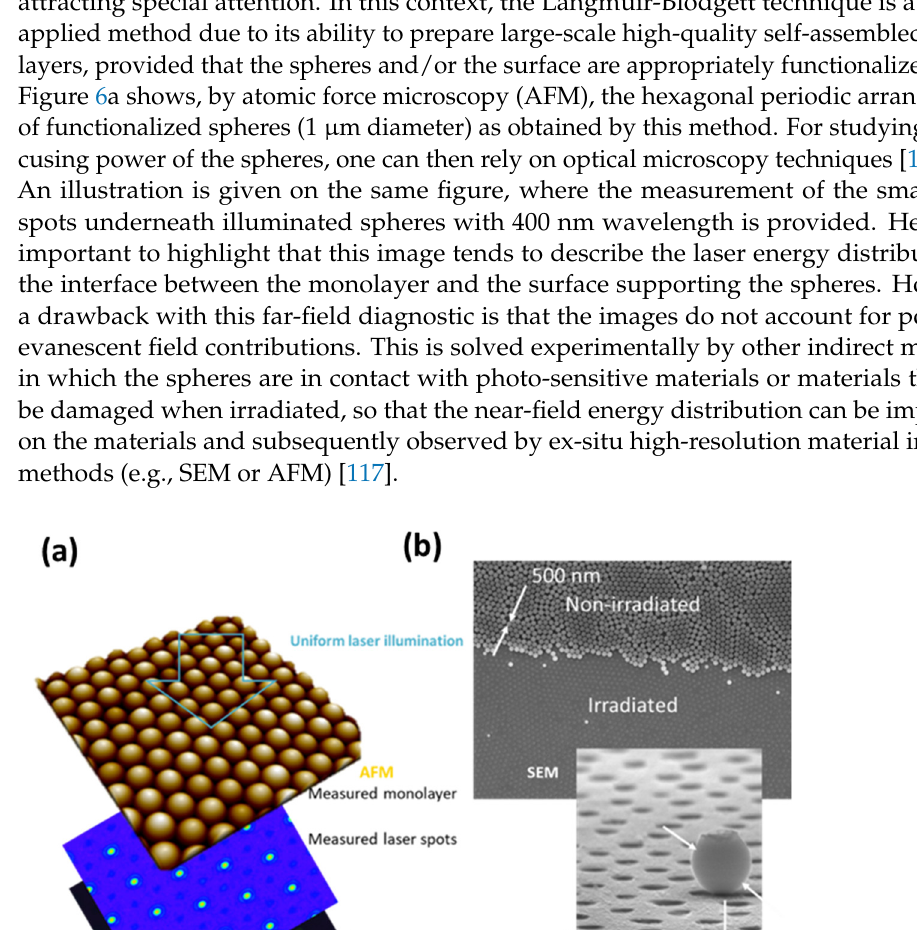
Figure 7. Nanofabrication by microsphere-laser joint methods. Most of the technologies in the panel of laser processing methods, that are additive, subtractive or corrective, can benefit from the focusing power of microspheres for large-scale synthesis of periodic structures at submicron scales. Inserted final structure images are extracted from references, all mentioned in the text. 3.3. Femtosecond Laser-Induced Bulk Modification in Transparent Materials for Biological Applications Complementing laser surface engineering methods to produce 2D (dimensional) or 2.5D structures, laser-induced bulk modification in transparent materials offers the possi- bility to add a large panel of new functionalities in the three dimensions of materials. This